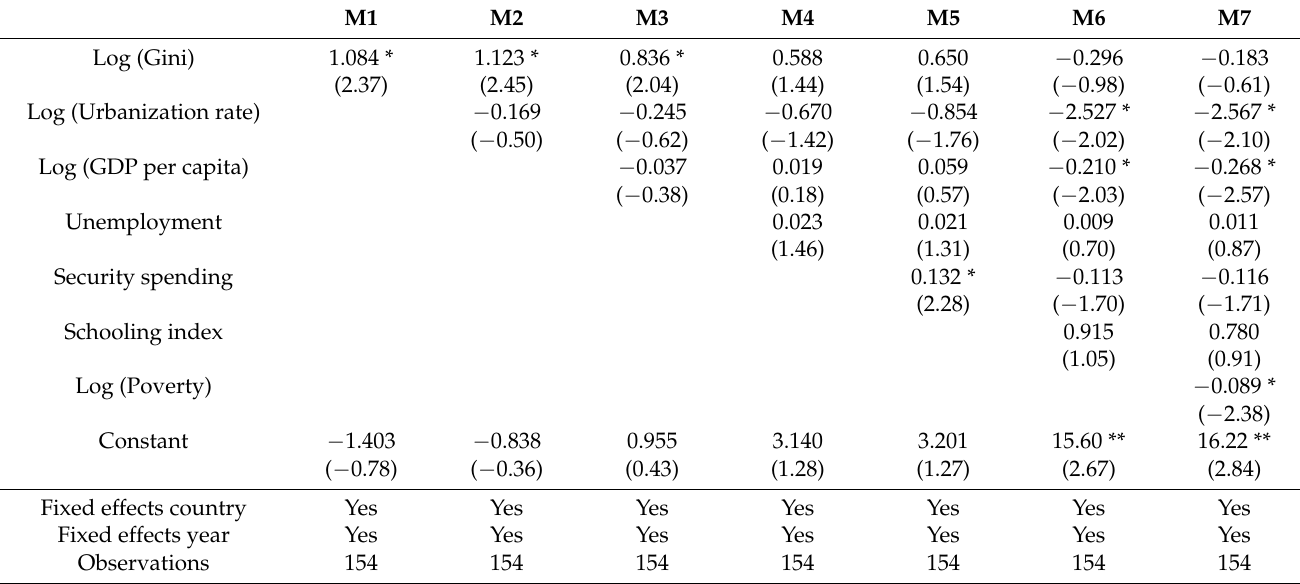
Table 6. Baseline regression of the GLS model with control variables for